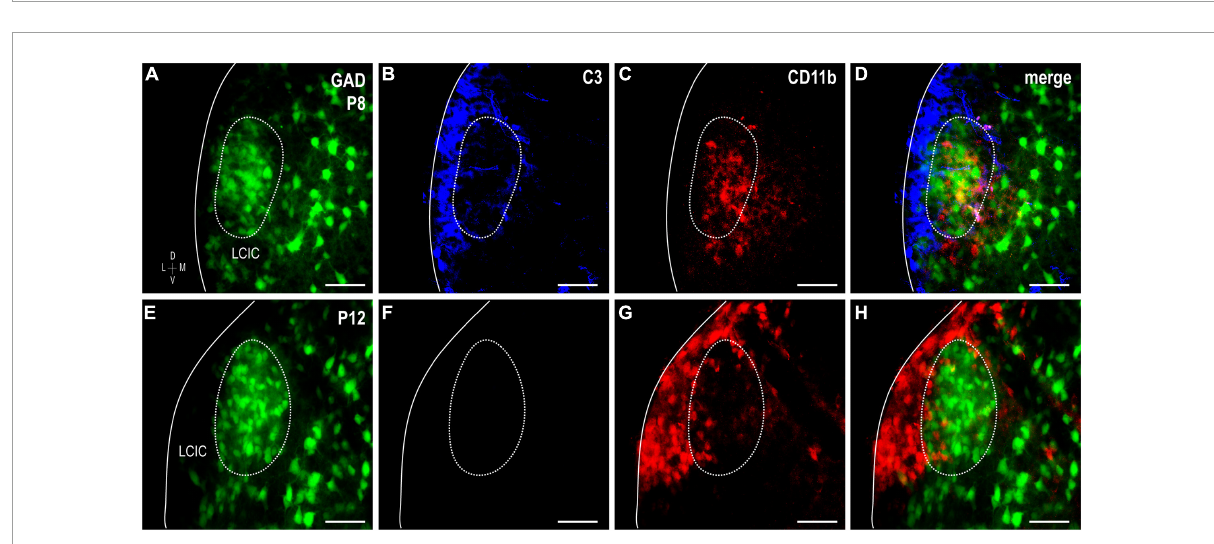
FIGURE5 Sequential complement component 3 (C3) compartmental clearance follows shift in integrin α M (CD11b)-expressing microglial cell (MGC) location. Double-labeling studies for C3 (blue) and CD11b (red) in glutamic acid decarboxylase (GAD)-GFP (green) mice at P8 (A–D) and P12 (E–H) . At P8, CD11b-positive microglia occupy GAD-defined modules, where C3 labeling is now weak compared to the surrounding matrix. By P12, CD11b-positive MGCs preferentially congregate in the matrix where C3 expression is now also unremarkable. Scale bars = 50 µ